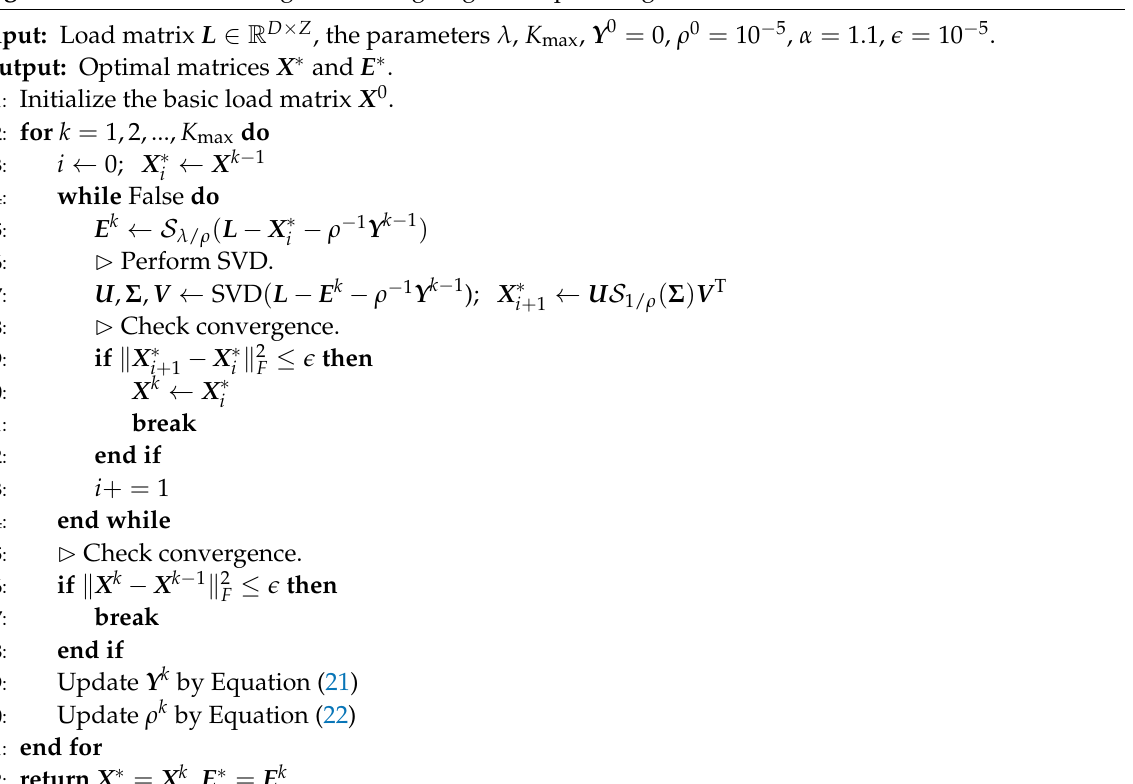
Algorithm 1 Distributed augmented Lagrange multipliers